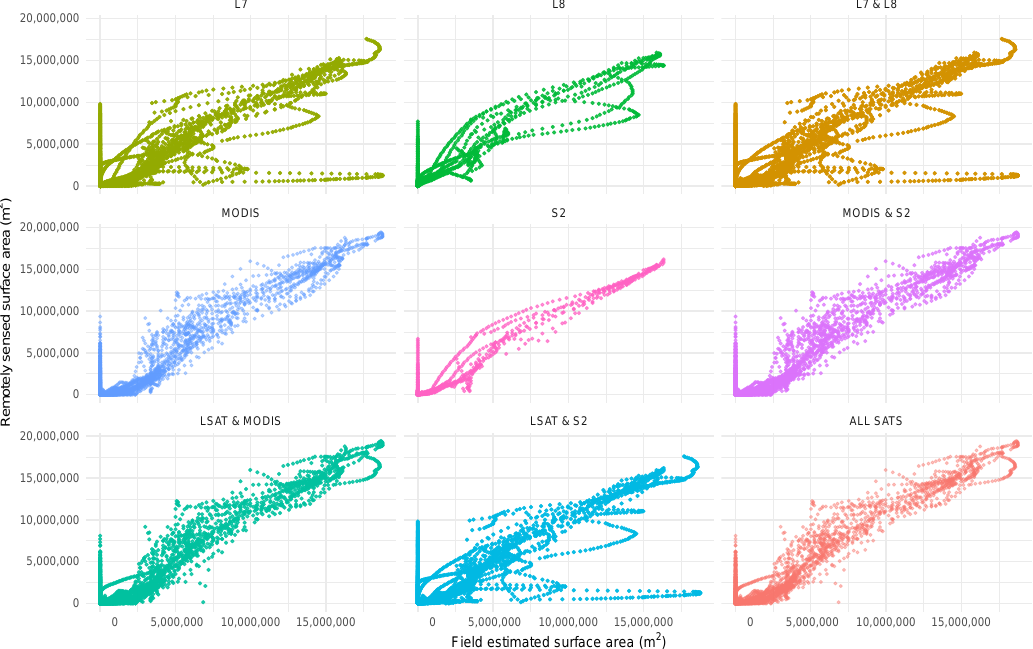
Figure 13. Scatterplot of daily interpolated remotely sensed flooded areas and ground truth data from each sensor and multi-sensor combinations